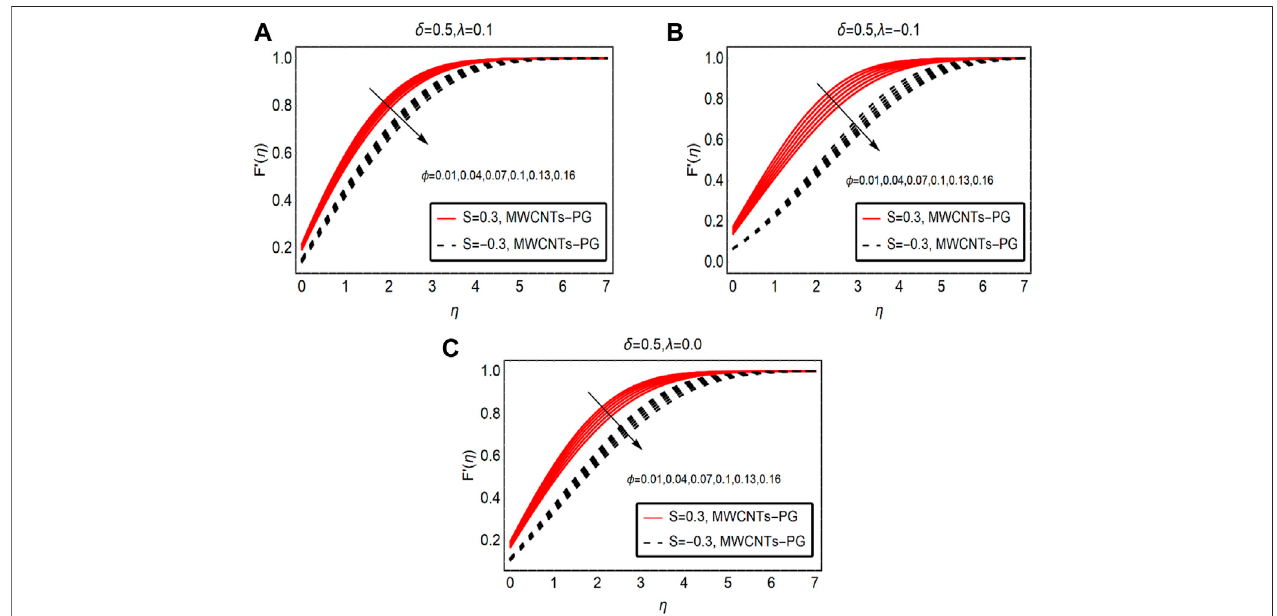
FIGURE 3 | F ′ ( η ) against ϕ (A) λ > 0 and (B) λ < 0 and (C) λ (cid:2) 0.